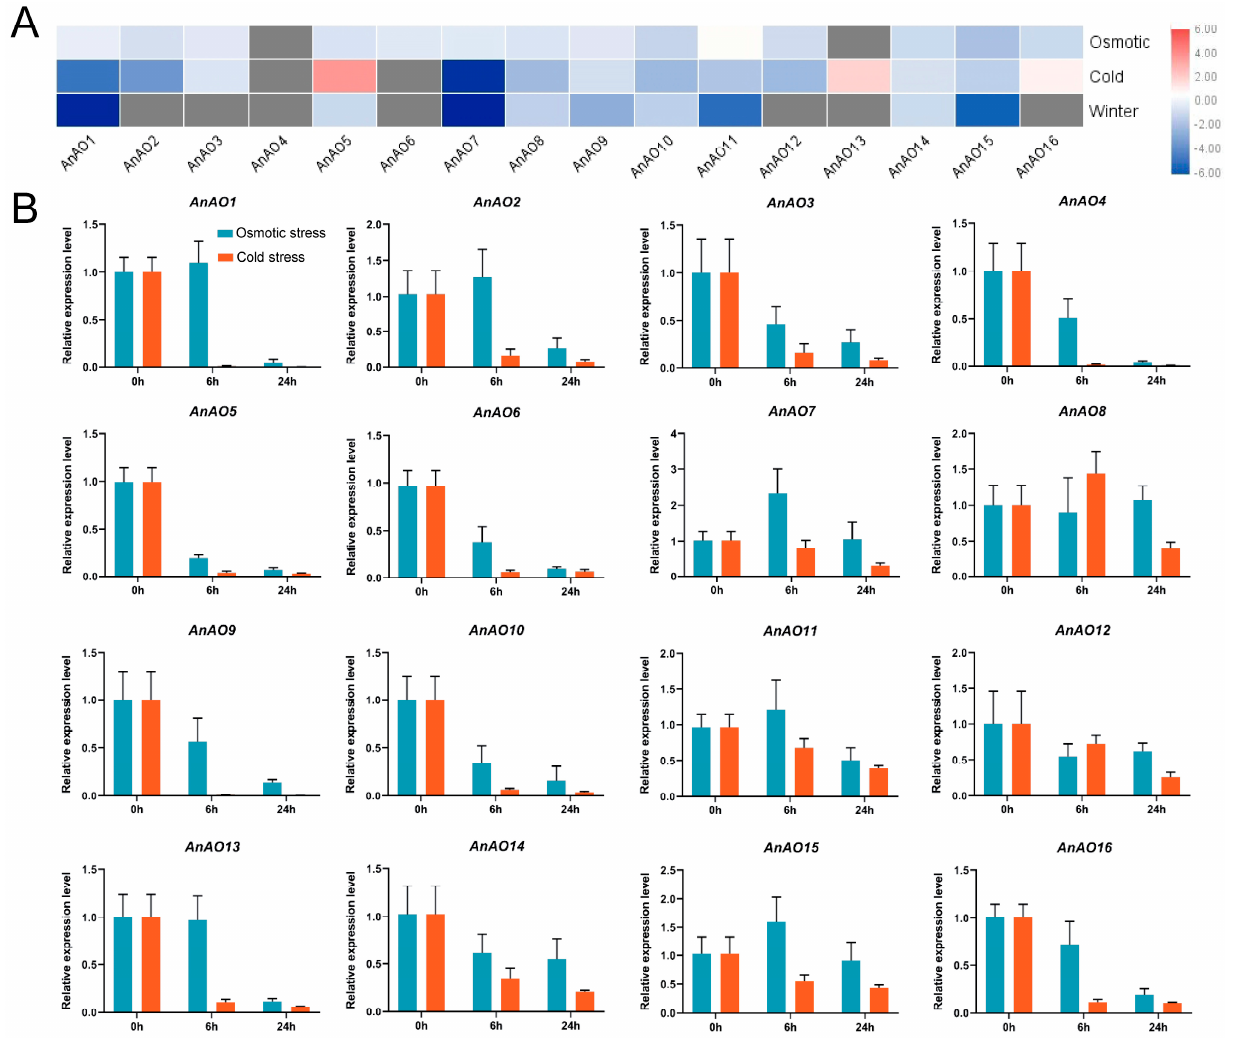
Figure 6. Expression analysis of AnAOs based on transcriptome data and qRT-PCR analysis. ( A ) Ex- pression patterns of AnAO genes under osmotic and cold stress for 7 d and during winter based on transcriptome data. ( B ) Expression patterns of AnAO genes under short-term osmotic stress and cold stress based on qRT-PCR analysis. Each experiment was performed in three independent biological replicates, and the error bar shows the SD ( n =